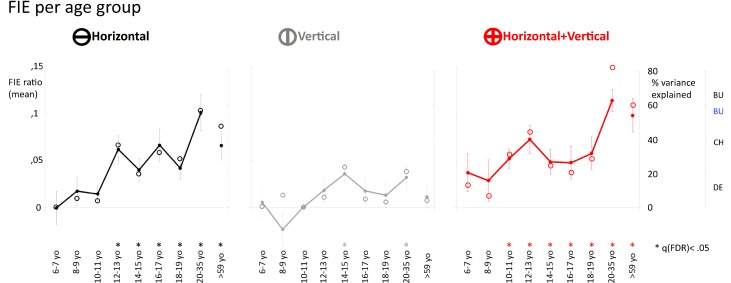
Mean and size of FIE ratio per age group.Full circles and lines illustrate the mean FIE ratio (in RT) in the different age groups separately for horizontal, vertical, and horizontal-vertical filtering conditions. Error bars represent standard errors of the means. Open circles depict FIE size (in terms of percentage of explained variance, or eta squared) for horizontal, vertical, and horizontal-vertical filtering conditions. BU, CH, and DE data points (on the right) depict the size of the FIE in RT in previous studies [42, 85, 86]. Participants were elderly adults In Busigny et al. (2011), young and elderly adults in Chaby et al. (2011), and they were children (aged between 6 and 12) and young adults in de Heering and Rossion (2012). Black BU data point illustrates FIE size in the delayed face matching task (experiment 2) of the article of Busigny and colleagues [85]; blue BU data point refers to FIE size as measured in a simultaneous face matching task (experiment 3) of the same paper. CH symbols illustrate findings of Chaby and colleagues [42] and DE symbols those of de Heering and Rossion [86]; the latter two articles used a delayed and simultaneous matching task, respectively.